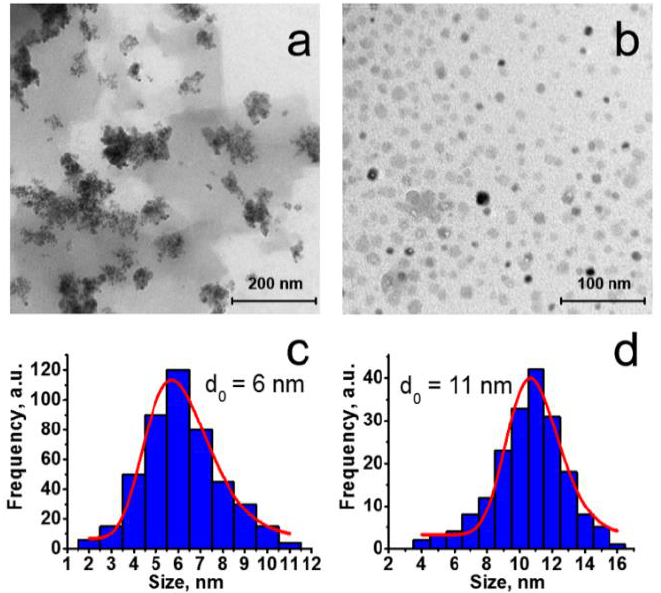
Figure 1. TEM images ( a,b ) and size distribution histograms ( c,d ) of dried samples of Au 2 Re 6 -S ( a,c ) and Au 2 Re 6 -Se ( b,d ) colloids. ( a,c ) and Au 2 Re 6 -Se ( b,d ) Table 1. Evaluated through the size distribution by number ( d num ) diameter values, polydispersity indices (PDI), and electrokinetic potentials ( ζ ) of Au 2 Re 6 -Q colloids both itself and after the addi- tion of lysozyme (LSZ) (1.6 µ M). Concentration of phosphate buffer is 0.01 M.